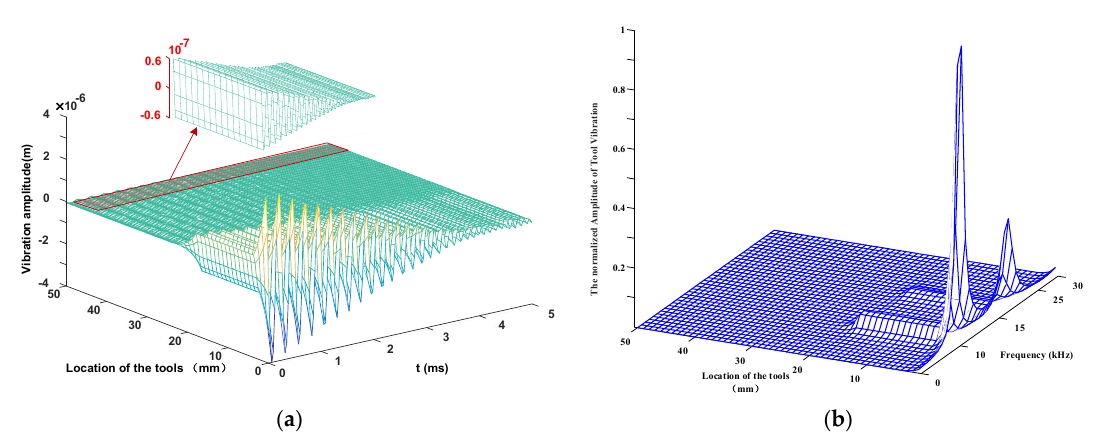
Figure 7. Vibration Propagation of Tool A. ( a ) Time domain transfer characteristic and ( b ) frequency domain transfer characteristics.